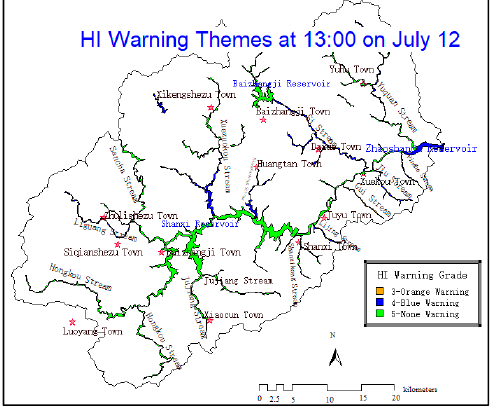
Figure 6. HI warning thematic maps.